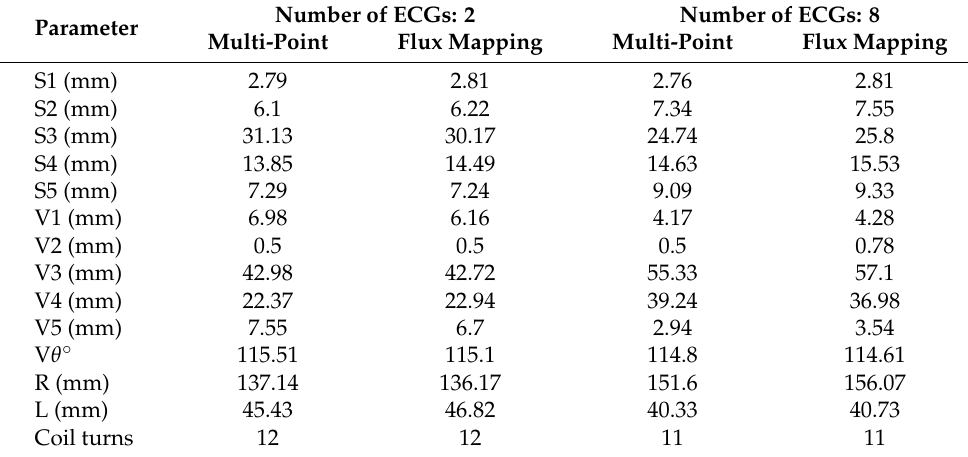
Figure 17. Pseudo-code for drive cycle energy consumption calculation. Table 8. Comparison of multi-point and flux mapping optimum designs with two and eight ECG